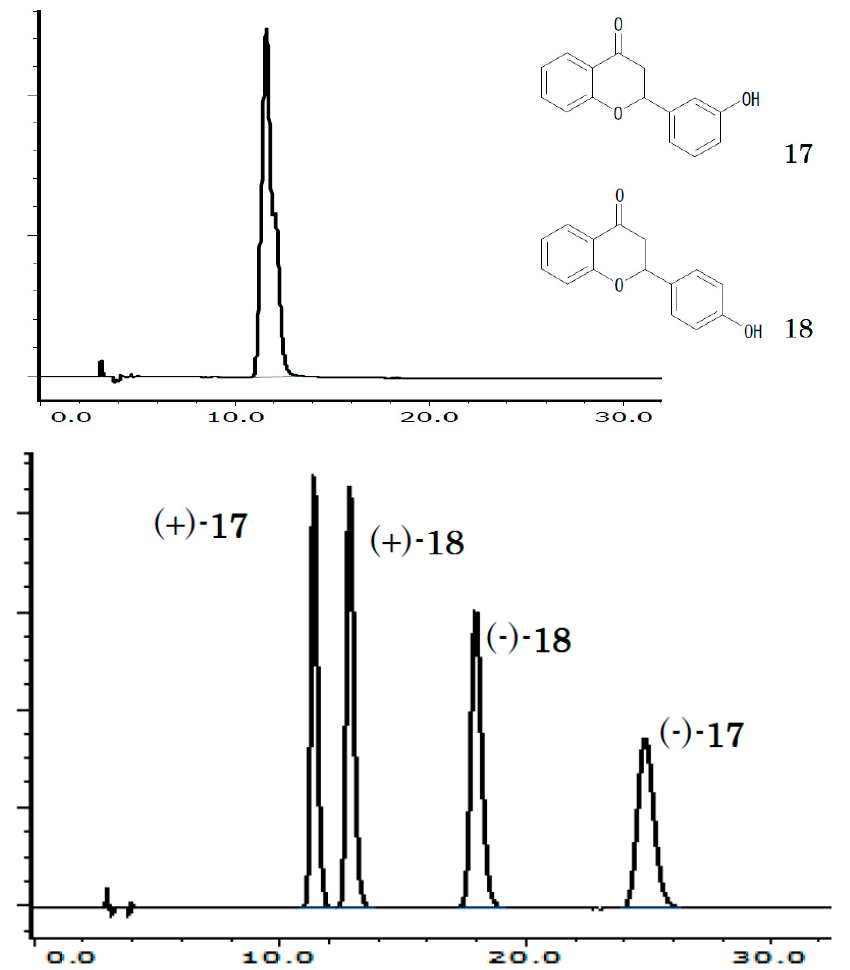
Figure 2. Chromatogram of racemic ( ± )-3'-hydroxyflavanone ( 17 ) and ( ± )-4'-hydroxy flavanone ( 18 ), upper on “OD-H” and lower on “AD-H”, each with hexane/ethanol/trifluoroacetic acid (80:20:0.1 v / v / v ), 1.0 mL/min at 40 °C.